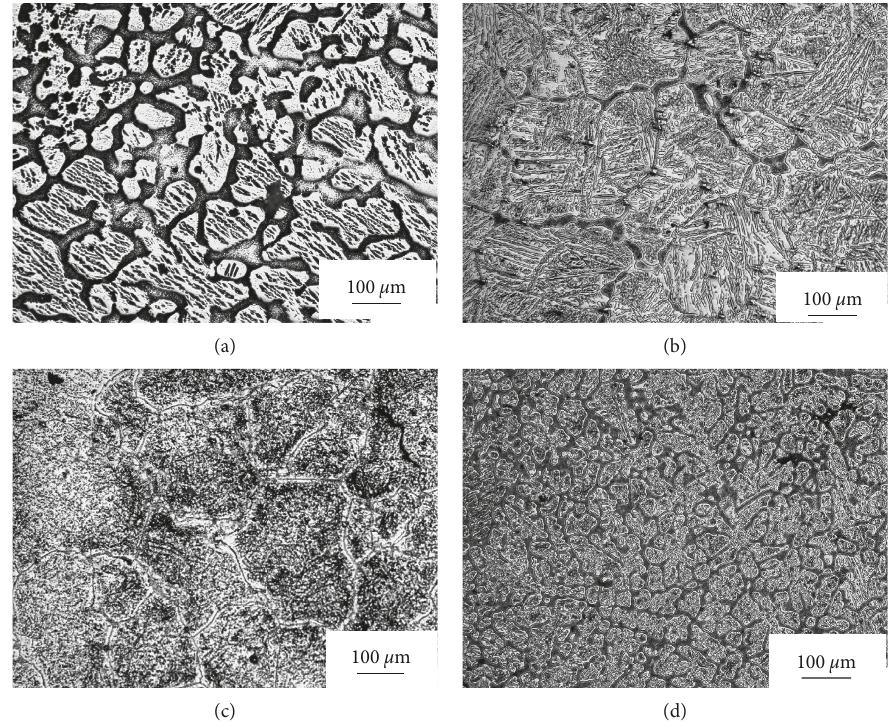
Figure 8: Optical micrographs of the 10h heat-treated samples: (a) C1, (b) C2, and (c) C3 at 30mm and (d) C1 at 5 mm.